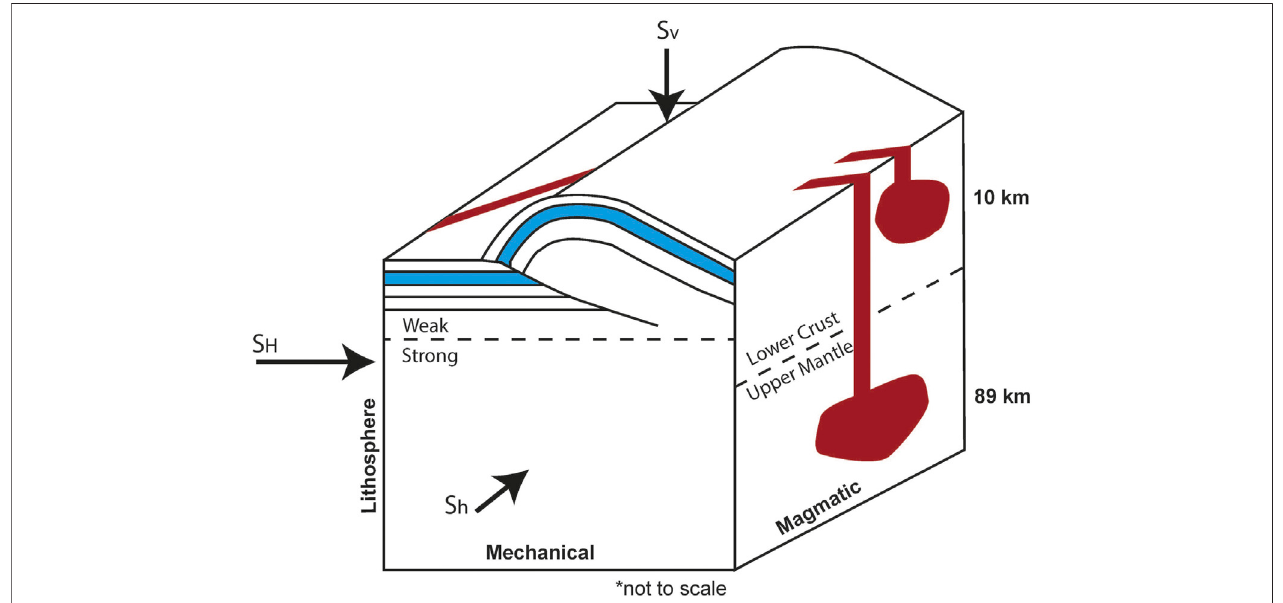
FIGURE 6 | This conceptual diagram (not to scale) shows dikes and thrust faults propagating simultaneously in a horizontally compressive stress regime where propagation distances range between 10 and 89 km, and the lithosphere through which dike propagation occurs is mechanically layered.